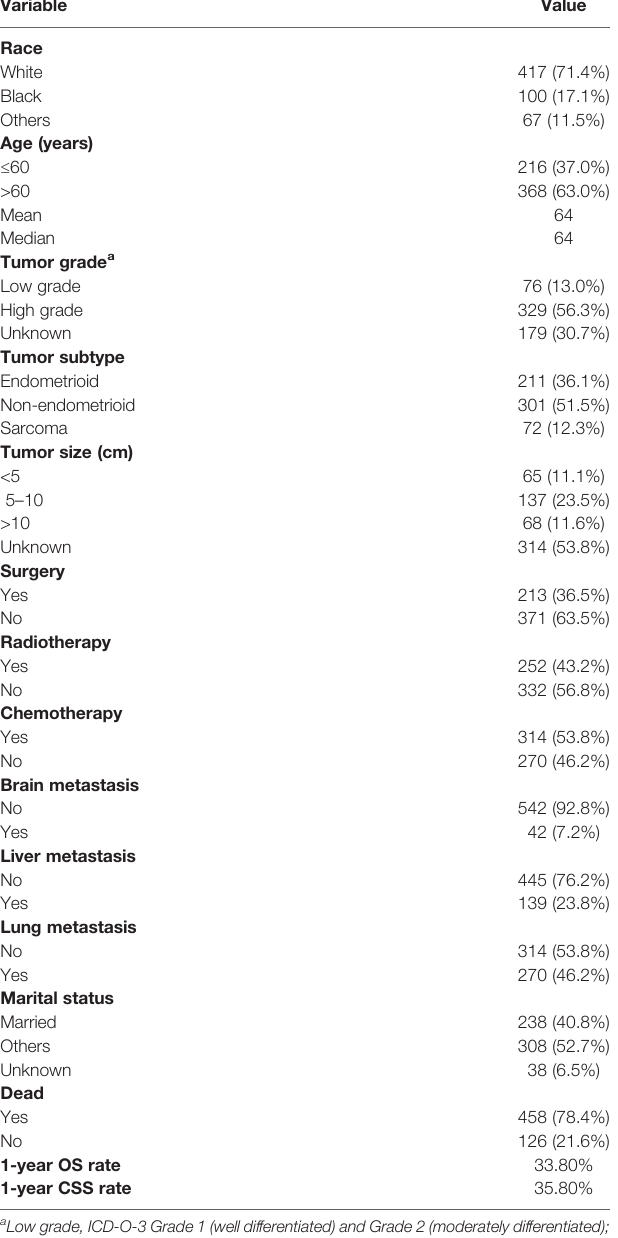
TABLE 1 | Baseline characteristics of 584 endometrial cancer bone